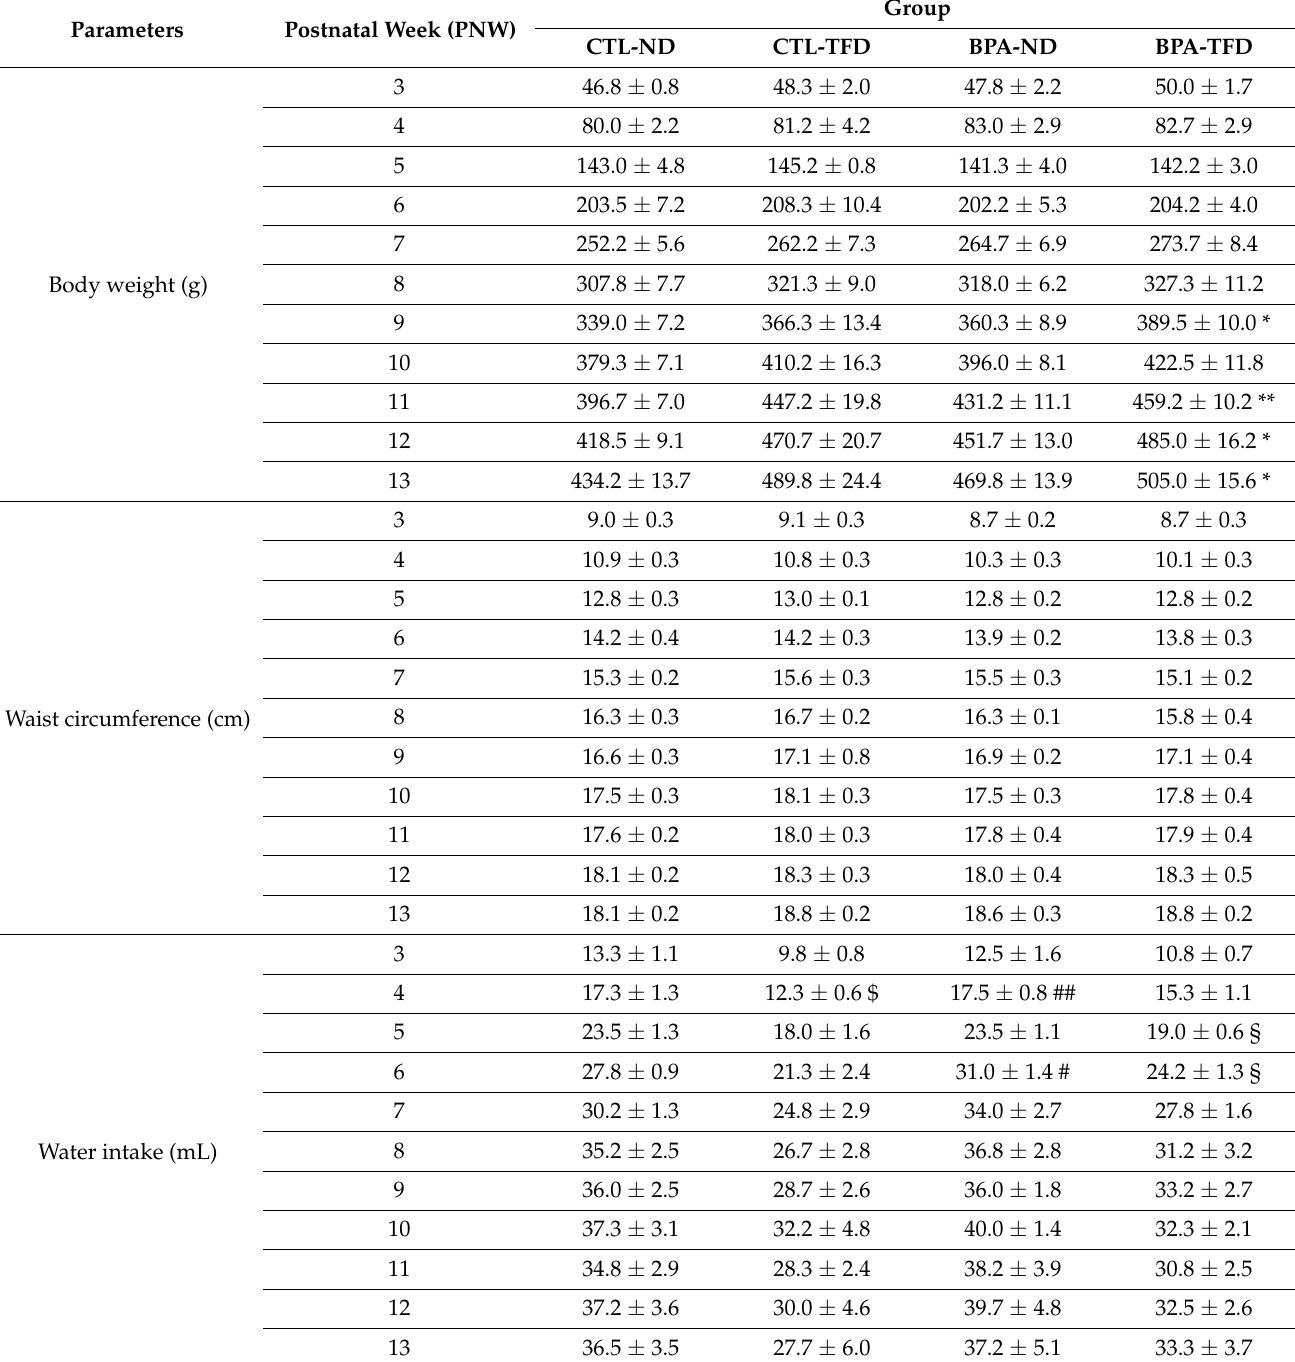
Table 1. Physiological parameters for obesity in offspring (comparisons between groups). Substantial differences in water and food intake were observed at earlier ages (PNW4–9; at adolescence), while significant differences in body weight were only observed at later ages (PNW9–13; at adulthood). Meanwhile, waist circumference was comparable among offspring groups ( n = 6 per